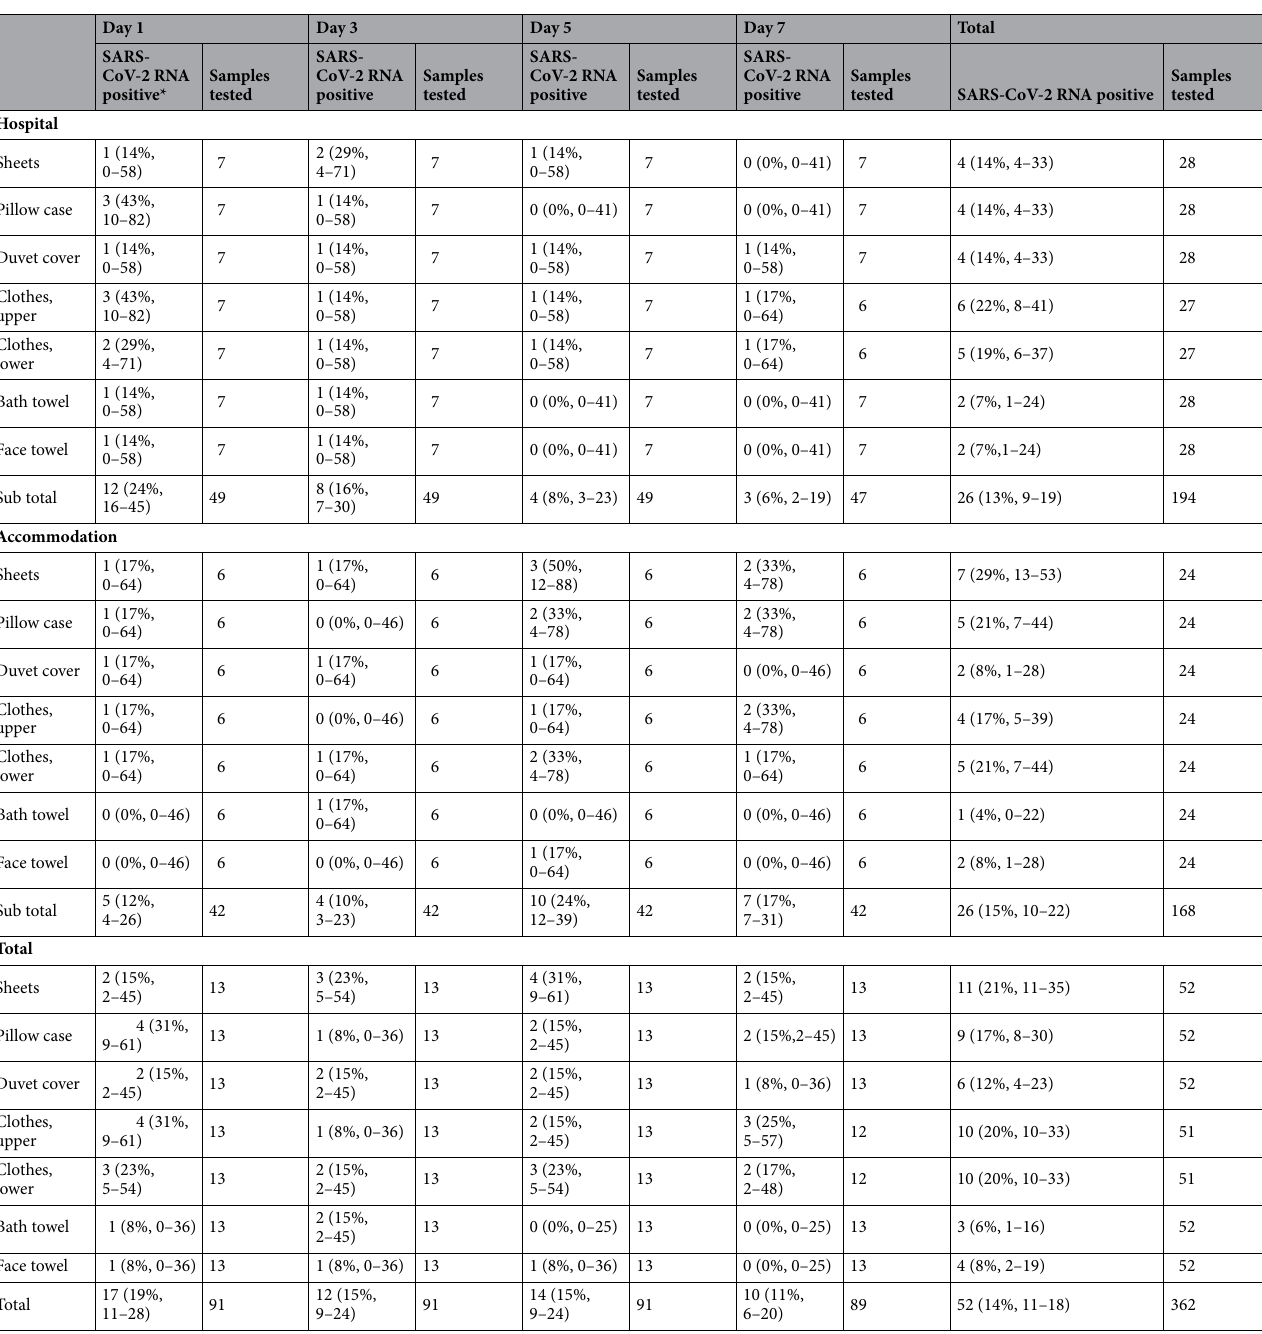
Table 2. SARS-CoV-2 RNA test results of the linens used by SARS-CoV-2-positive patients. Fisher’s exact test showed no significant difference in the RNA detection proportion for all linens between the accommodation and hospital. The Cochran–Armitage test showed a significant difference in the trend of RNA detection proportion in the hospital (p = 0.0018) but not in the accommodation (p = 0.25) and total result (p = 0.19). *The number of positive samples (percentage of positive samples, 95% confidence intervals for the